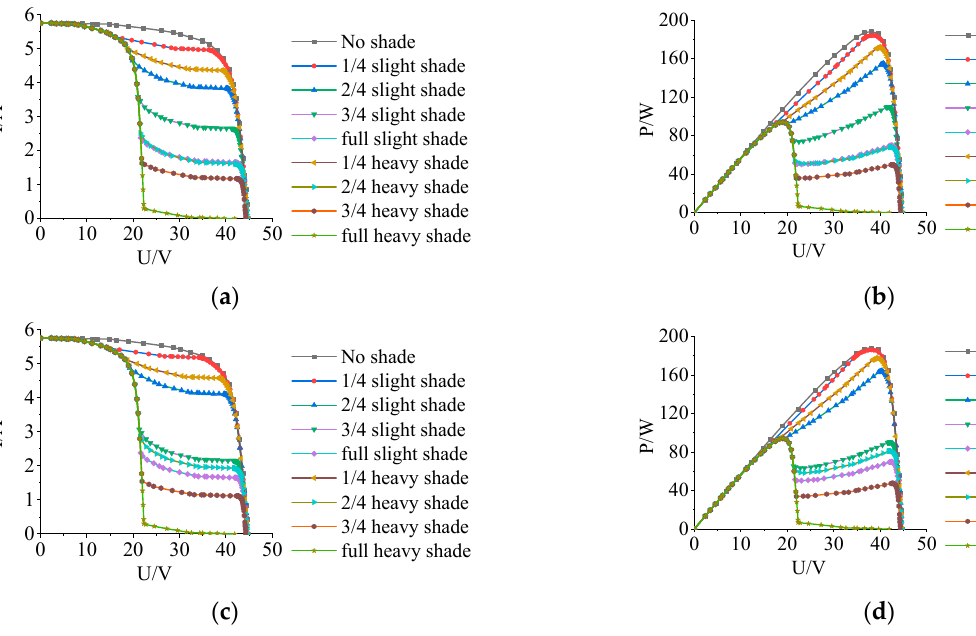
Figure 13. The output current–voltage and power–voltage curves of the PV module string in ( a , b ) lateral and ( c , d ) longitudinal shading conditions.